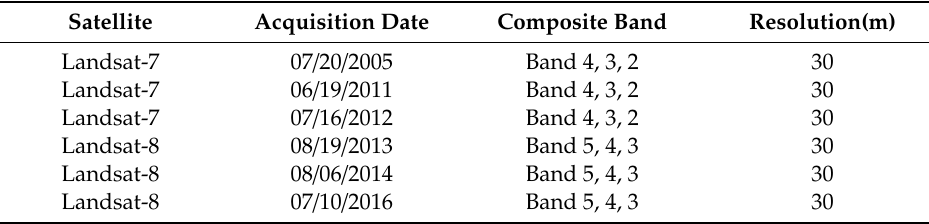
Table 3. Landsat image list used in this